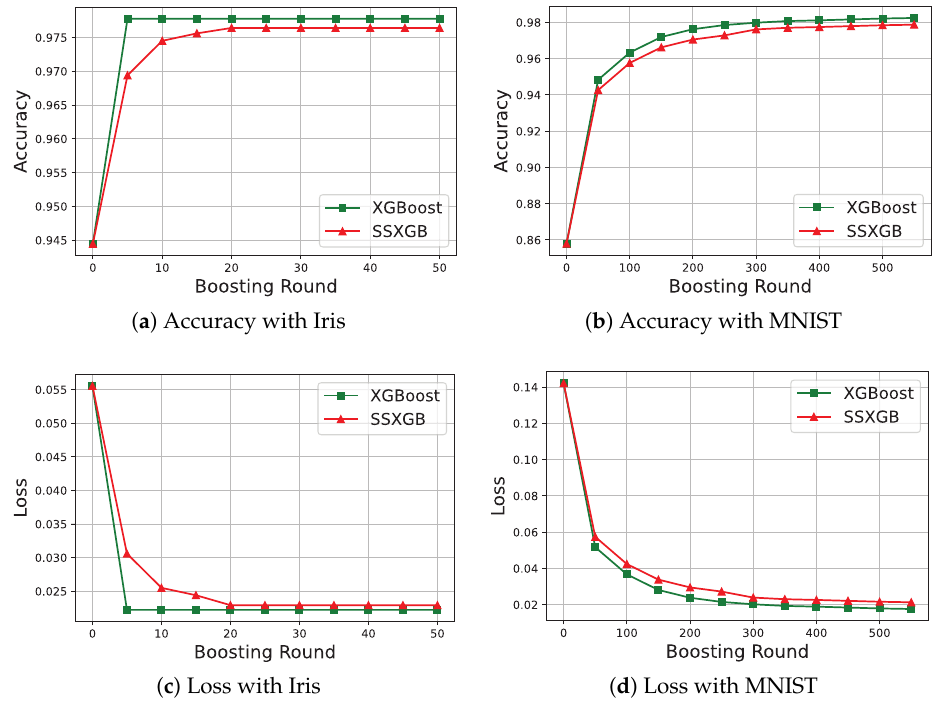
Figure 3. Training convergence with the Iris and MNIST